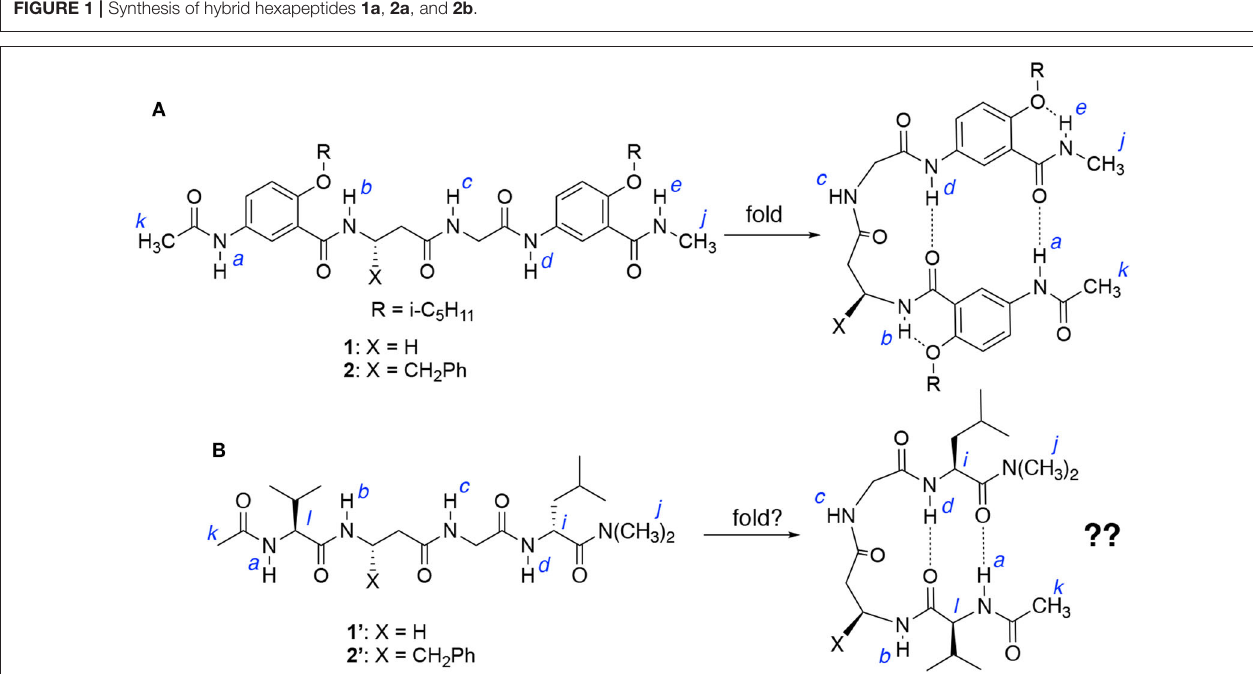
FIGURE 2 | (A) Hybrid tetrapeptides 1 and 2 were found to fold into a hairpin conformation as shown. (B) Hybrid tetrapeptides 1 ′ and 2 ′ are designed to probe whether folded (hairpin) conformations could also be adopted.